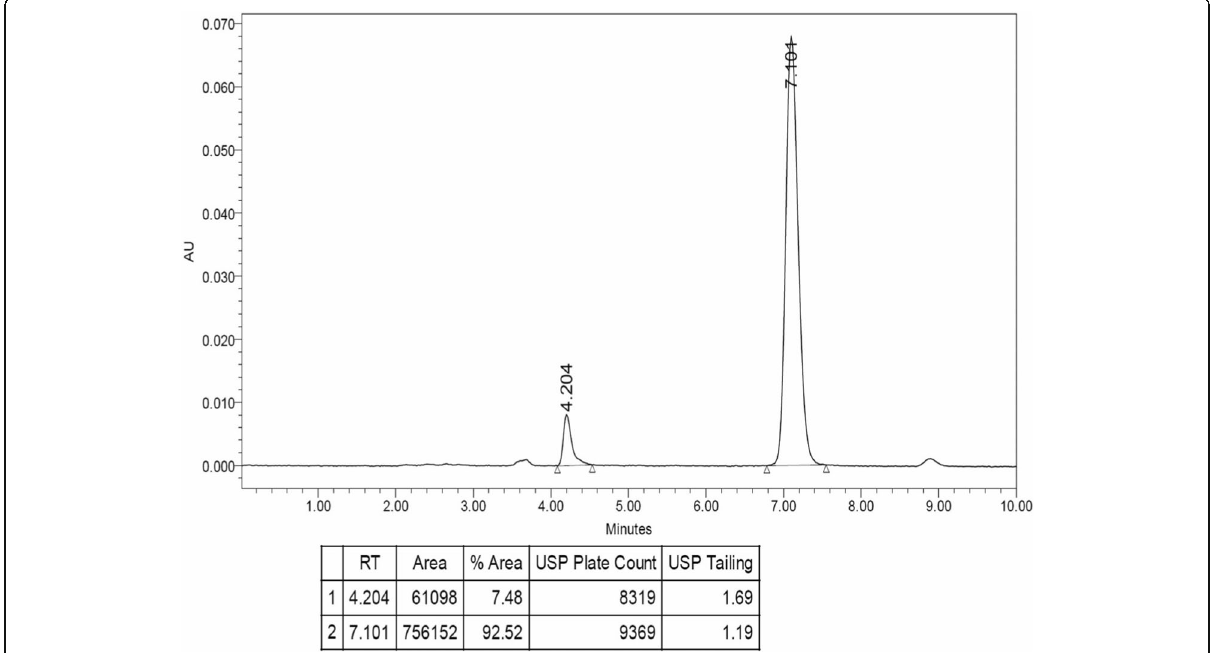
Fig. 3 Chromatogram showing peak of free naringenin associated with the PLGA nanoparticles. Naringenin entrapped was calculated after subtracting the amount of free drug from the total amount of drug in nanoparticles. The method uses methanol and 0.5% ortho-phosphoric acid in triple distilled water as mobile phase in the ratio (70:30). The chromatogram was detected at 289 nm and the analysis was performed at 30 °C (column oven temperature), with a flow rate of 1 ml/min and injection volume of 20 μ